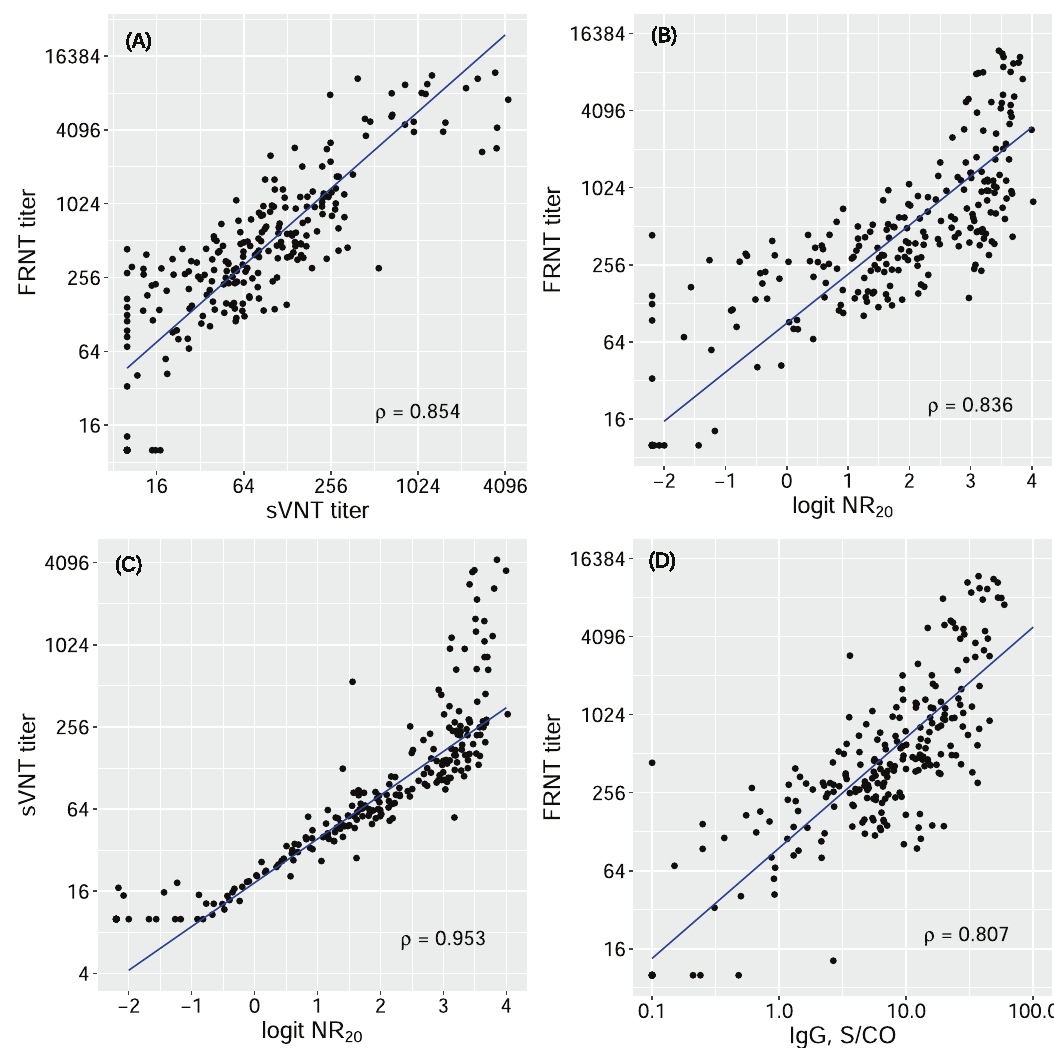
Fig. 1 Correlations among different measurements of NAbs and IgG against SARS-CoV-2. A NAbs IC 50 titer by focus reduction neutralization test (FRNT) vs NAbs IC 50 titer by surrogate virus neutralization test (sVNT); B NAbs IC 50 titer by FRNT vs logit of sVNT neutralization rate at 1:20 dilution of sera (logit NR 20 ); C NAbs IC 50 titer by sVNT vs logit NR 20 ; D NAbs IC 50 titer by FRNT vs the level of total binding IgG. The blue lines are the regression lines between two measurements estimated by Deming regression. ρ Spearman ’ s correlation coef fi cients, S/CO ratio of the chemiluminescence signal over the cutoff (Table 2). The decline rates were similar between genders and strata of severity. Overall, NAbs declined with a half-time of 61 days (95% CI: 49 to 80 days) within the fi rst two months post onset and 104 days (95% CI: 86 to 130 days) afterward. Unlike NAbs, the declining rates of IgG and IgM were not time-dependent. The decay half-time of IgG and IgM was 95 days (95% CI: 85 to 108 days) and 42 days (95% CI: 39 to 47 days), respectively.